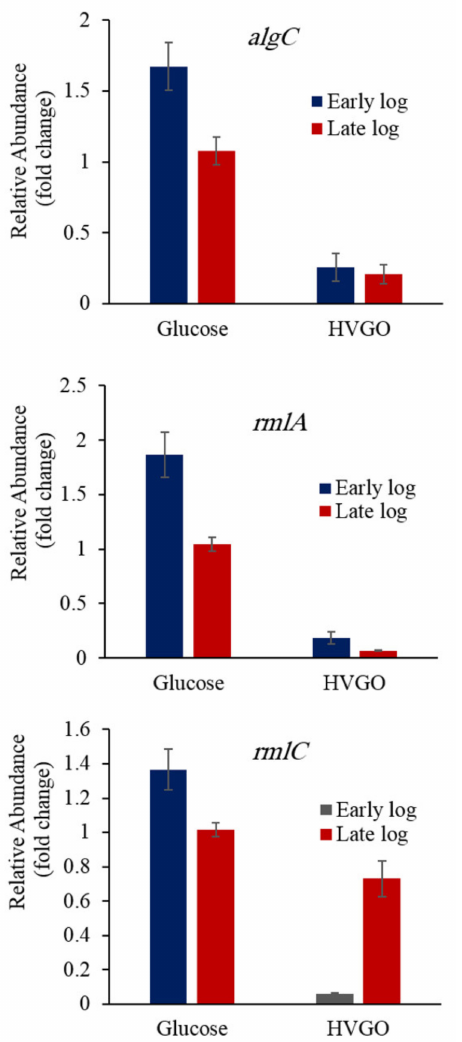
Figure 4. Relative expression of rhamnose biosynthesis genes in the glucose and HVGO cultures of strain AK6U during the early and late log phases of growth. Error bars represent standard error (number of replicates =